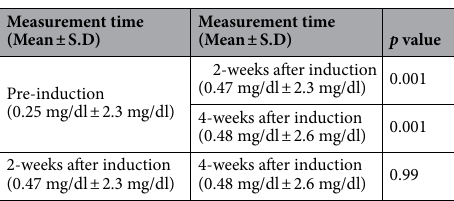
Table 9. Compares the mean of direct bilirubin before and after induction.